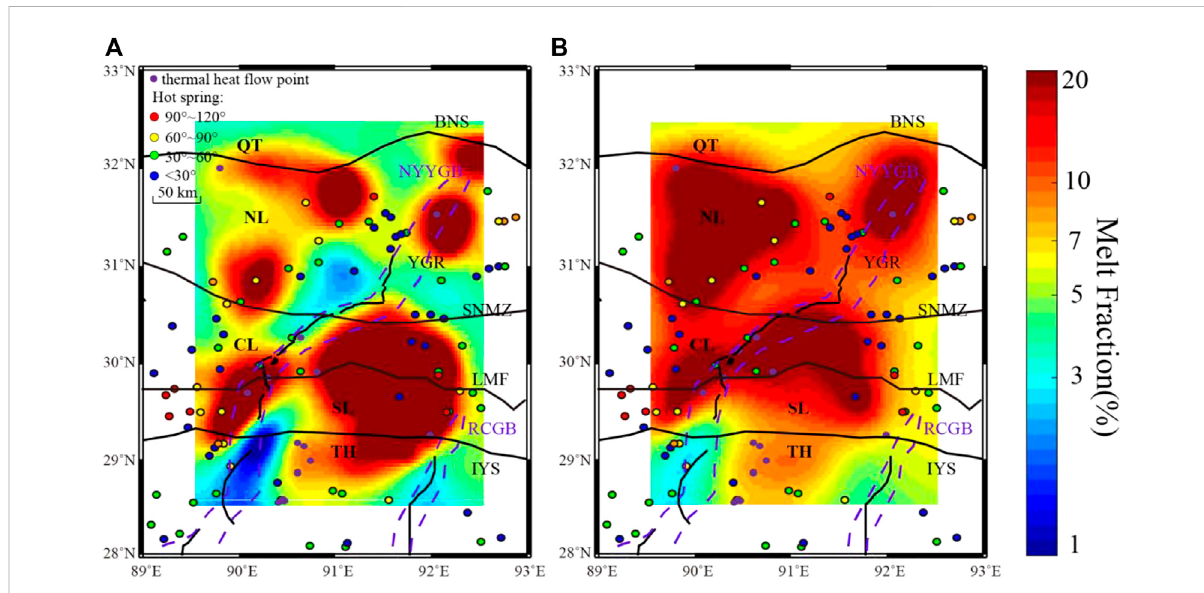
FIGURE 13 The meltfraction inthemid-lower crust. (A) Horizontal distribution of meltfraction inthemiddle crust(~30 – 45 km). (B) Horizontal distribution of melt fraction in the lower crust (~45 – 70